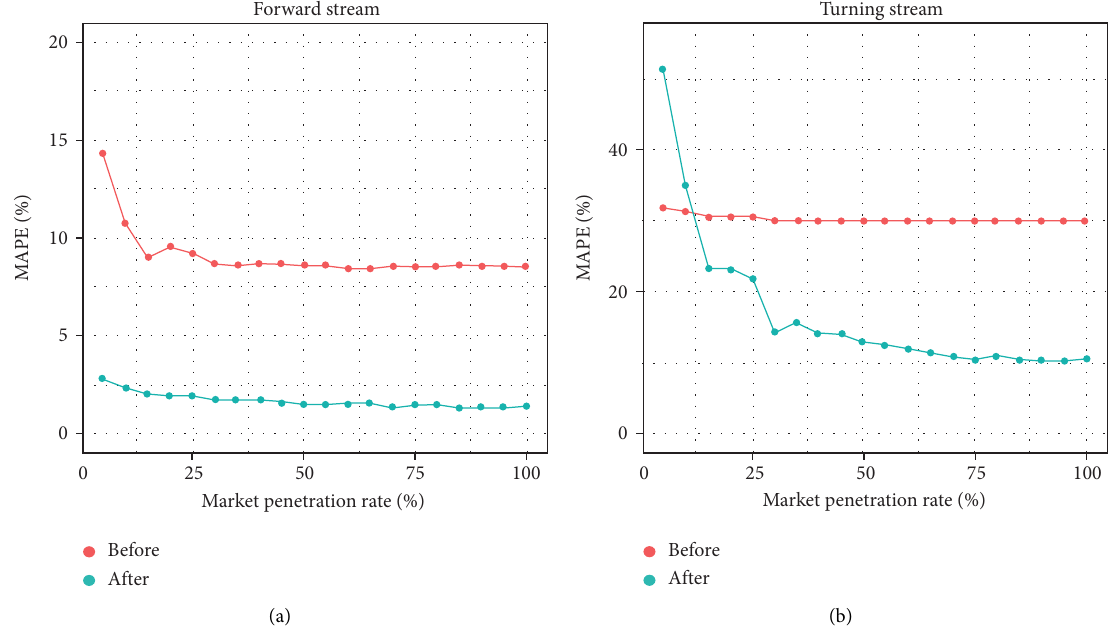
Figure 11: MAPE values of travel time estimation before and after applying the proposed framework. (a) Forward stream estimation at different MPRs. (b) Turning stream estimation at different